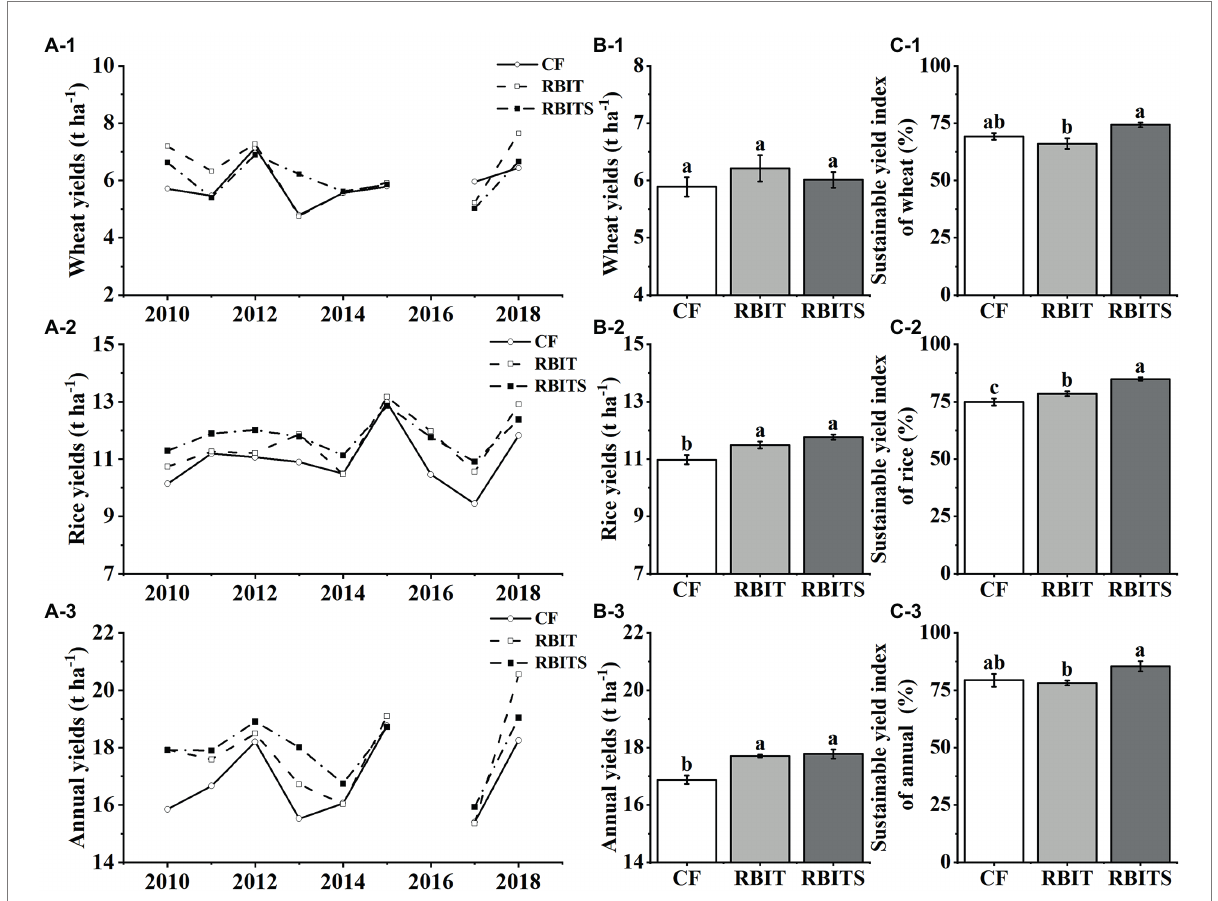
FIGURE 2 Effects of fertilization management on wheat, rice, and annual yield and their sustainable yield indexes. CF : conventional fertilization; RBIT: reduced basal and increased topdressing fertilizer rate; RBITS: RBIT combined with straw incorporation. (A-C) Show each year’s yield, the 9–year average yield, and the sustainable yield index, respectively. (1-3) Show wheat, rice, and annual data, respectively. Different lowercase letters represent significant differences ( p ≤ 0.05) among treatments for the same crop type. Error bars are standard error (SE) of the